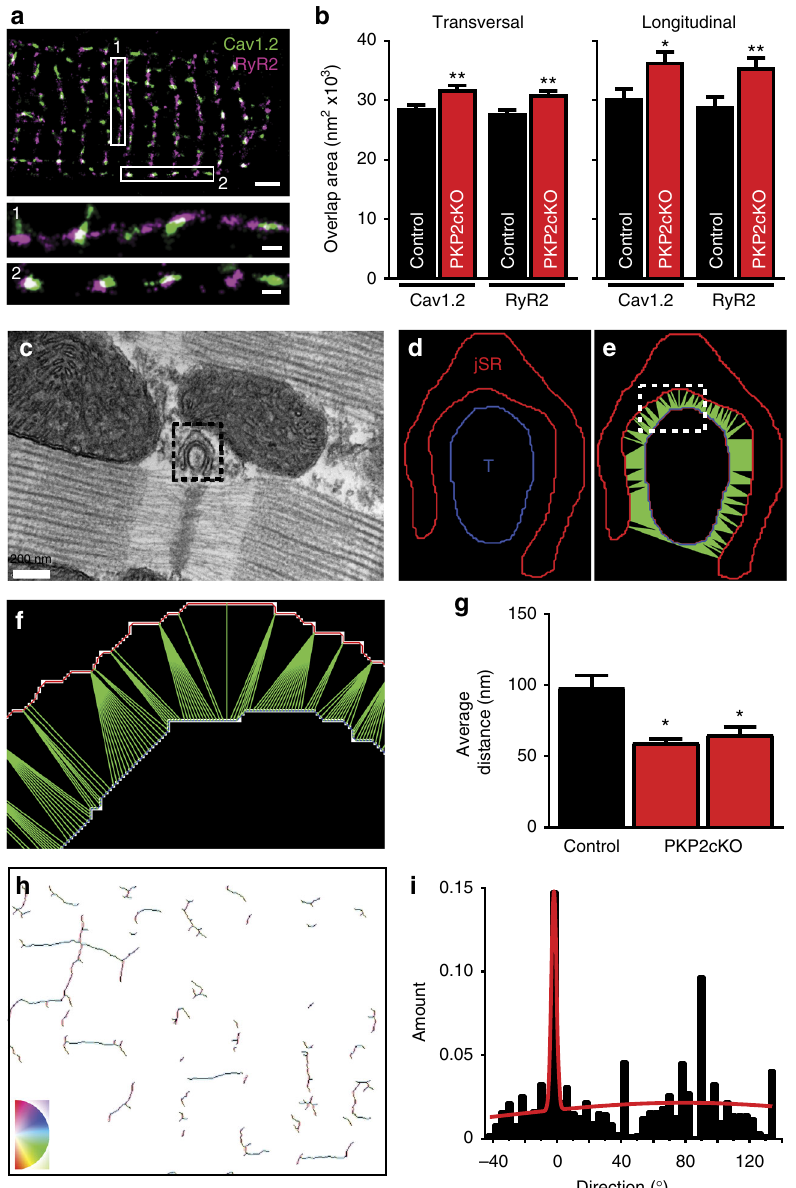
Fig. 5 Structural changes consequent to PKP2 deletion. a STORM-acquired images of Cav1.2 ( green ) and RyR2 ( purple ) in a single myocyte. b Analysis of RyR2/Cav1.2 overlapping area in transverse ( left ) and longitudinal ( right ) clusters. n = 1335 and 1285 clusters from 30 control and 25 PKP2-cKO cardiomyocytes at 21 dpi, respectively. t -test, * p < 0.05 and ** p < 0.01 vs. control. c 2D-EM image of PKP2-cKO ventricular tissue at 21 dpi showing a dyadic structure. Scale bar = 200 nm. d Boundaries of the jSR ( red ) and T-tubule ( blue ) membranes, detected from the dyad in the dotted square in c . e Acquisition of distances from each point in the T-tuble membrane to its closest neighbor in the jSR ( green lines ). f Close-up of the region inside the dashed square in e . All distances measured within a dyad were averaged to obtain the “ average distance ” for that dyad (expressed in nm). g Comparison of average data collected from one control ( n = 30 dyads) and 2 PKP2-cKO 21 dpi samples ( n = 41 dyads for both). Student ’ s t -test * p < 0.001 vs. control. h Spatial orientation of the T-tubular network, obtained from segmentation and analysis of a volume of 15 × 12 × 0.8 µ m 3 dimensions obtained by Serial Block-Face Scanning Electron Microscopy analysis. See also Supplementary Video 1 and “ Methods ” . The angle of the T-tubular skeleton is color-coded ( bottom left ) from − 90° in magenta to +90° in red ; relative to the longitudinal axis of the cell ( light blue ; 0°). i Histogram of orientations (from h ), showing a strong preference for zero-degree orientation, as expected from a non-failing heart (see ref. 60